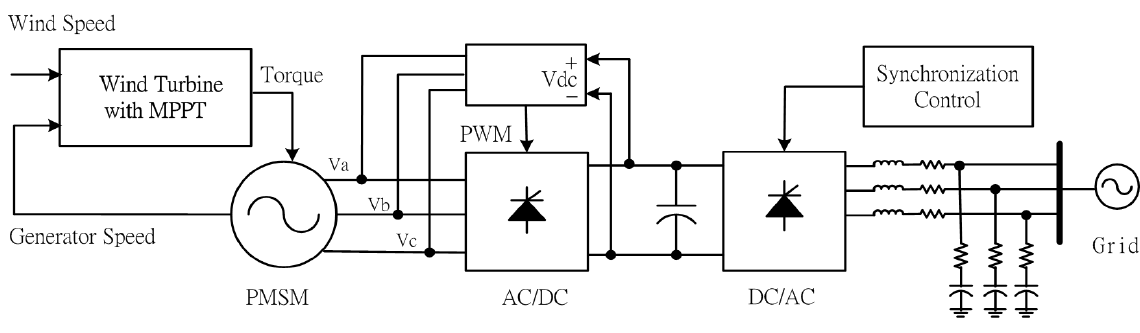
Figure A2. Control structure of 25-kW wind-turbine generators (WTG).